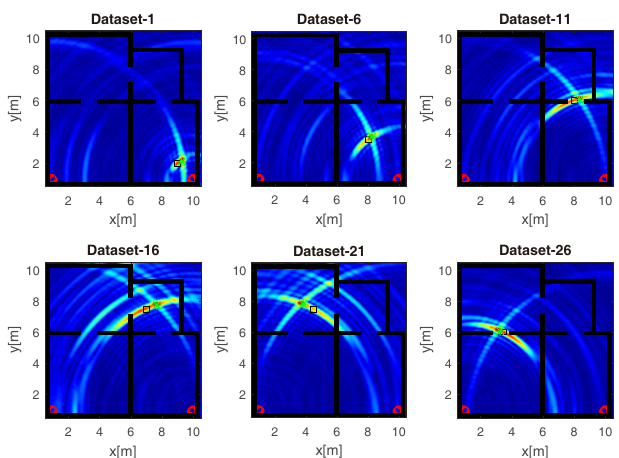
Figure 16. Tomographic images of a UWB source achieved with additive-array image fusion (D). Arrays (red circles); true source position (black square); estimated source position (green asterisk). Color scale is [0, 1].